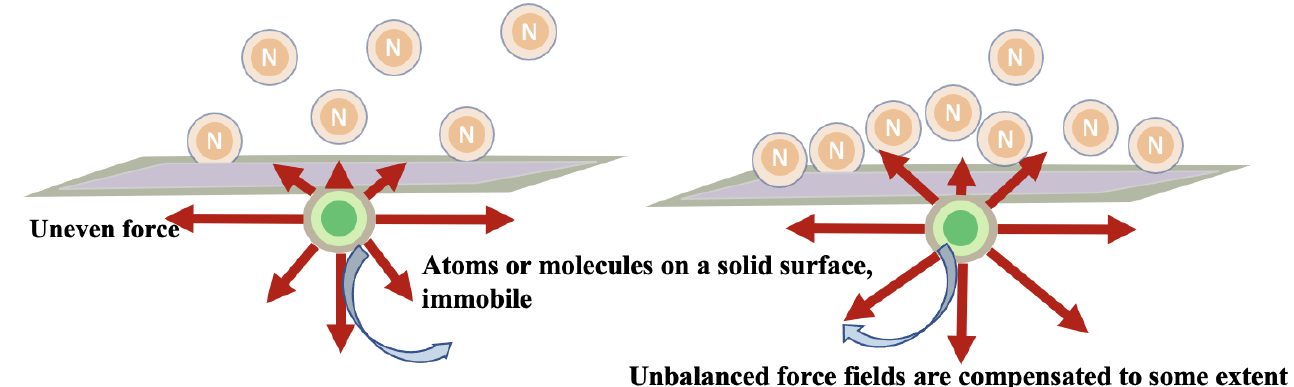
Figure 3. A schematic representation of the adsorption principle.